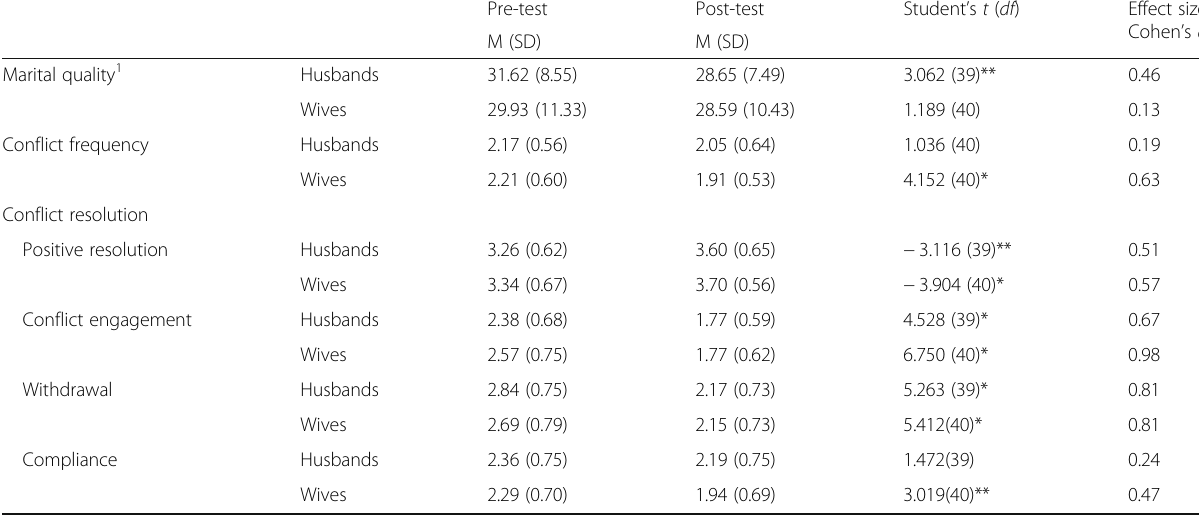
Table 4 Comparison between husbands and wives scores in the pre-test and the post-test